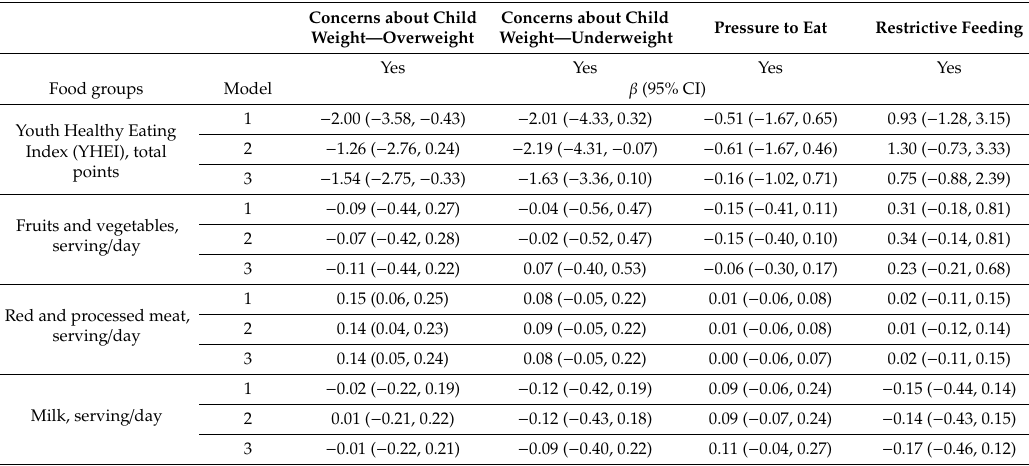
Table 3. Adjusted a linear regression coe ffi cients ( β (95% CI)) for associations of parental feeding concerns and behaviors at 2 years and child’s diet quality (reference group is the absence of concerns or of the behavior) and food groups intakes at early childhood (mean 3.2, SD 0.3 years) among participants from Project